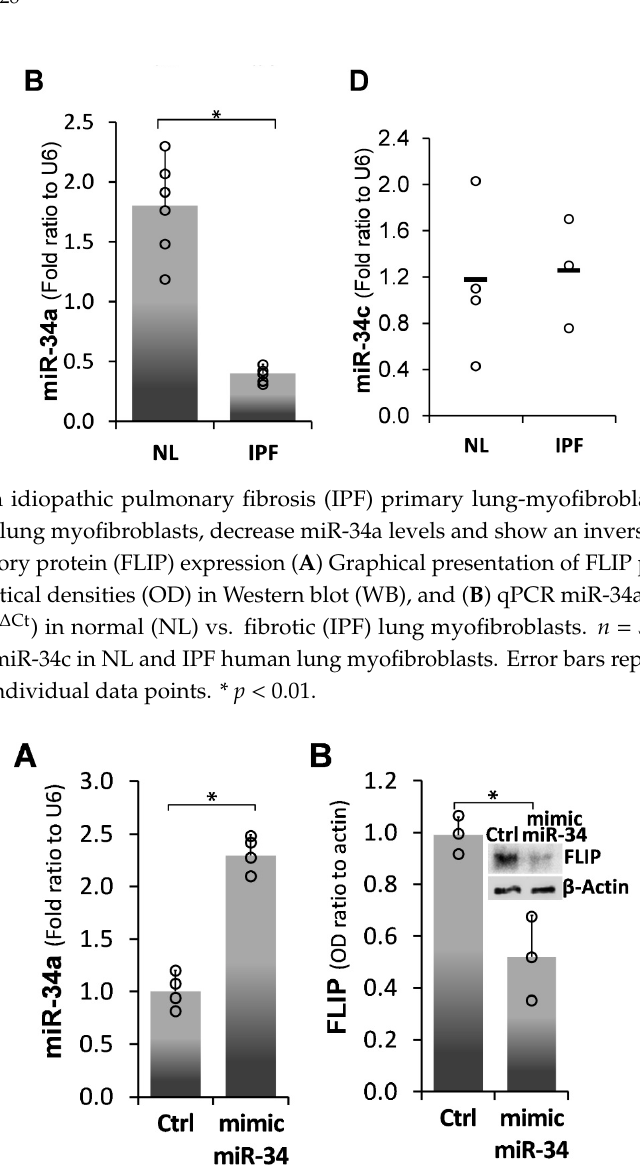
Figure 2. miR ‐ 34a mimic ‐ forced miR ‐ 34a overexpression in fibrotic IPF lung myofibroblasts decreases FLIP levels. ( A ) Graphical presentation of miR ‐ 34a levels in qPCR (calculated as 2 −∆∆ Ct ) in mimic miR ‐ 34a ‐ transfected CCL ‐ 191 cells (IPF cell line). ( B ) Graphical presentation and Western blot ( B; insert) of FLIP expression. Representative results from four independent experiments. Error bars represent mean ±SD; circles represent individual data points. * p < 0.01–0.05.